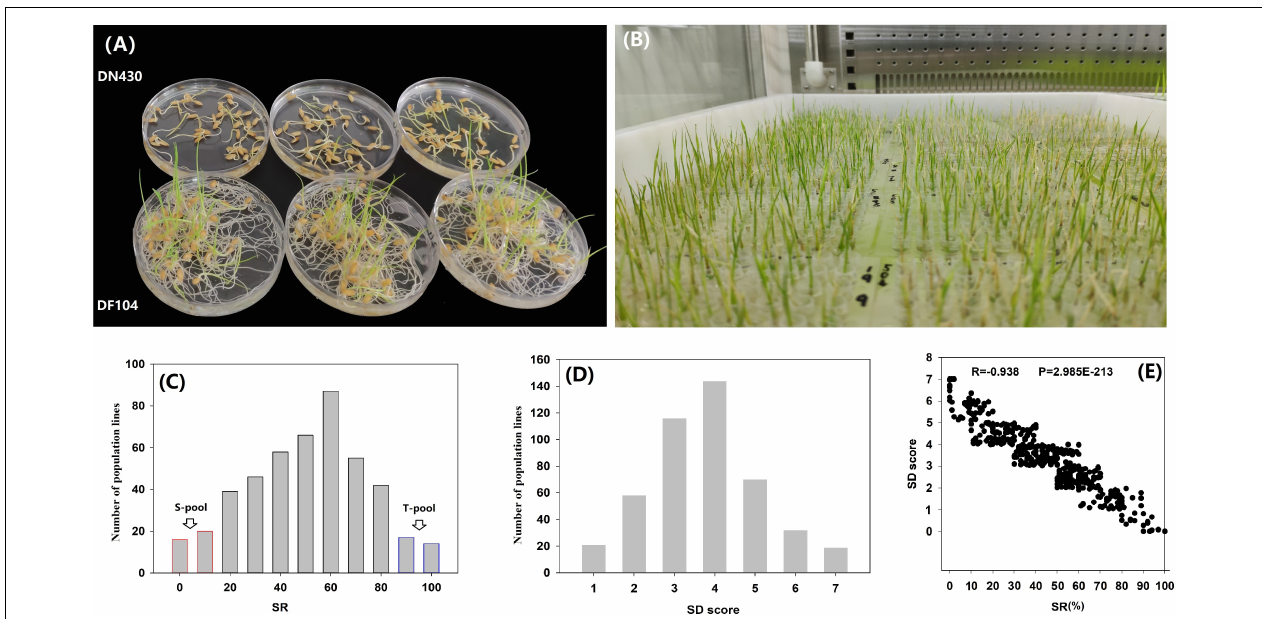
FIGURE 1 | Phenotypic analysis of cold tolerance in rice bud-bursting stage. (A) The performance of DN420 and DF104 under cold treatment (5 ◦ C/9 days). (B) Identification of cold tolerance of F 2 population in artificial climate chamber. (C,D) Frequency distribution of seed survival rate (SR) and severity of damage (SD) variation measured among 460 mapping individuals of F 2 : 3 populations. (E) Paired scatter plot analysis of SR and SD. T-Pool, DNA pool of cold-tolerant lines, S-pool, and DNA pool of cold-sensitive